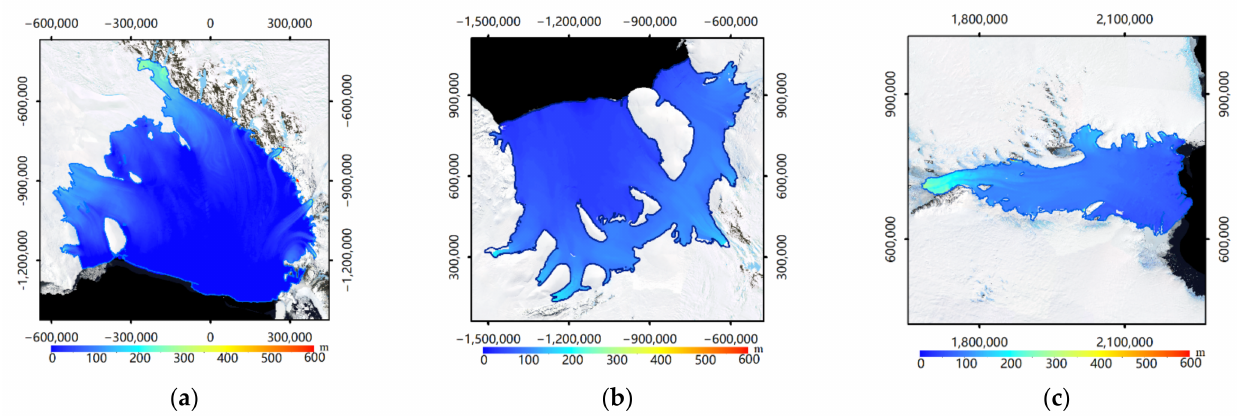
Figure 5. RIS DEM ( a ), FRIS DEM ( b ), and AIS DEM ( c ) at a resolution of 100 m derived from ICESat-2. The black area is the ocean; the blue line is the corrected coastline. Maps are in the polar stereographic projection in